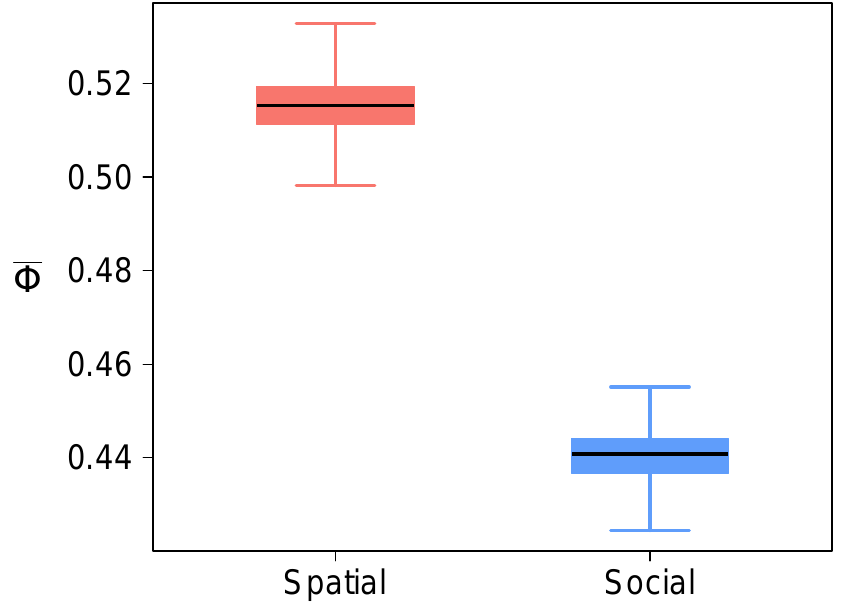
Figure A10. Boxplots of ¯ Φ for the spatial and social interaction matrices. Each boxplot is composed of 100 ¯ Φ values, each of them obtained with a Φ h value based on one random assignment. Each boxplot is composed of the minimum value, the first quartile, the median, the third quartile, and the maximal